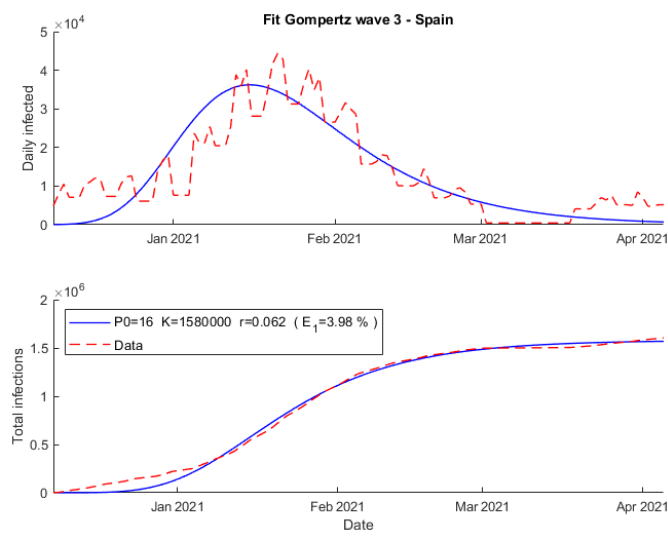
Figure 5. Fit using Gompertz’s model wave 3 COVID-19 Spain.